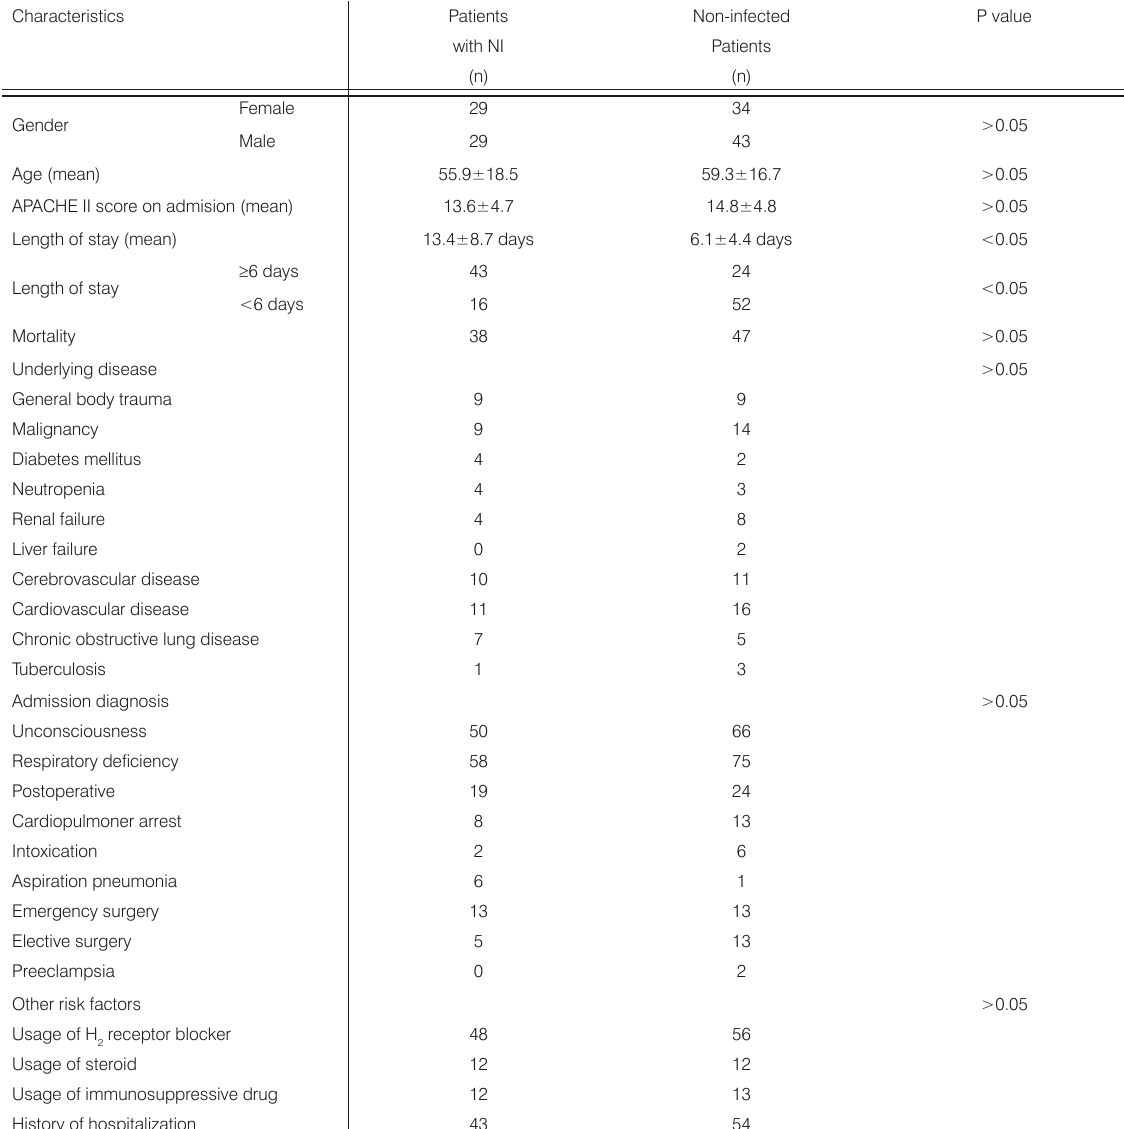
Table 1. Characteristics of patients involved in the